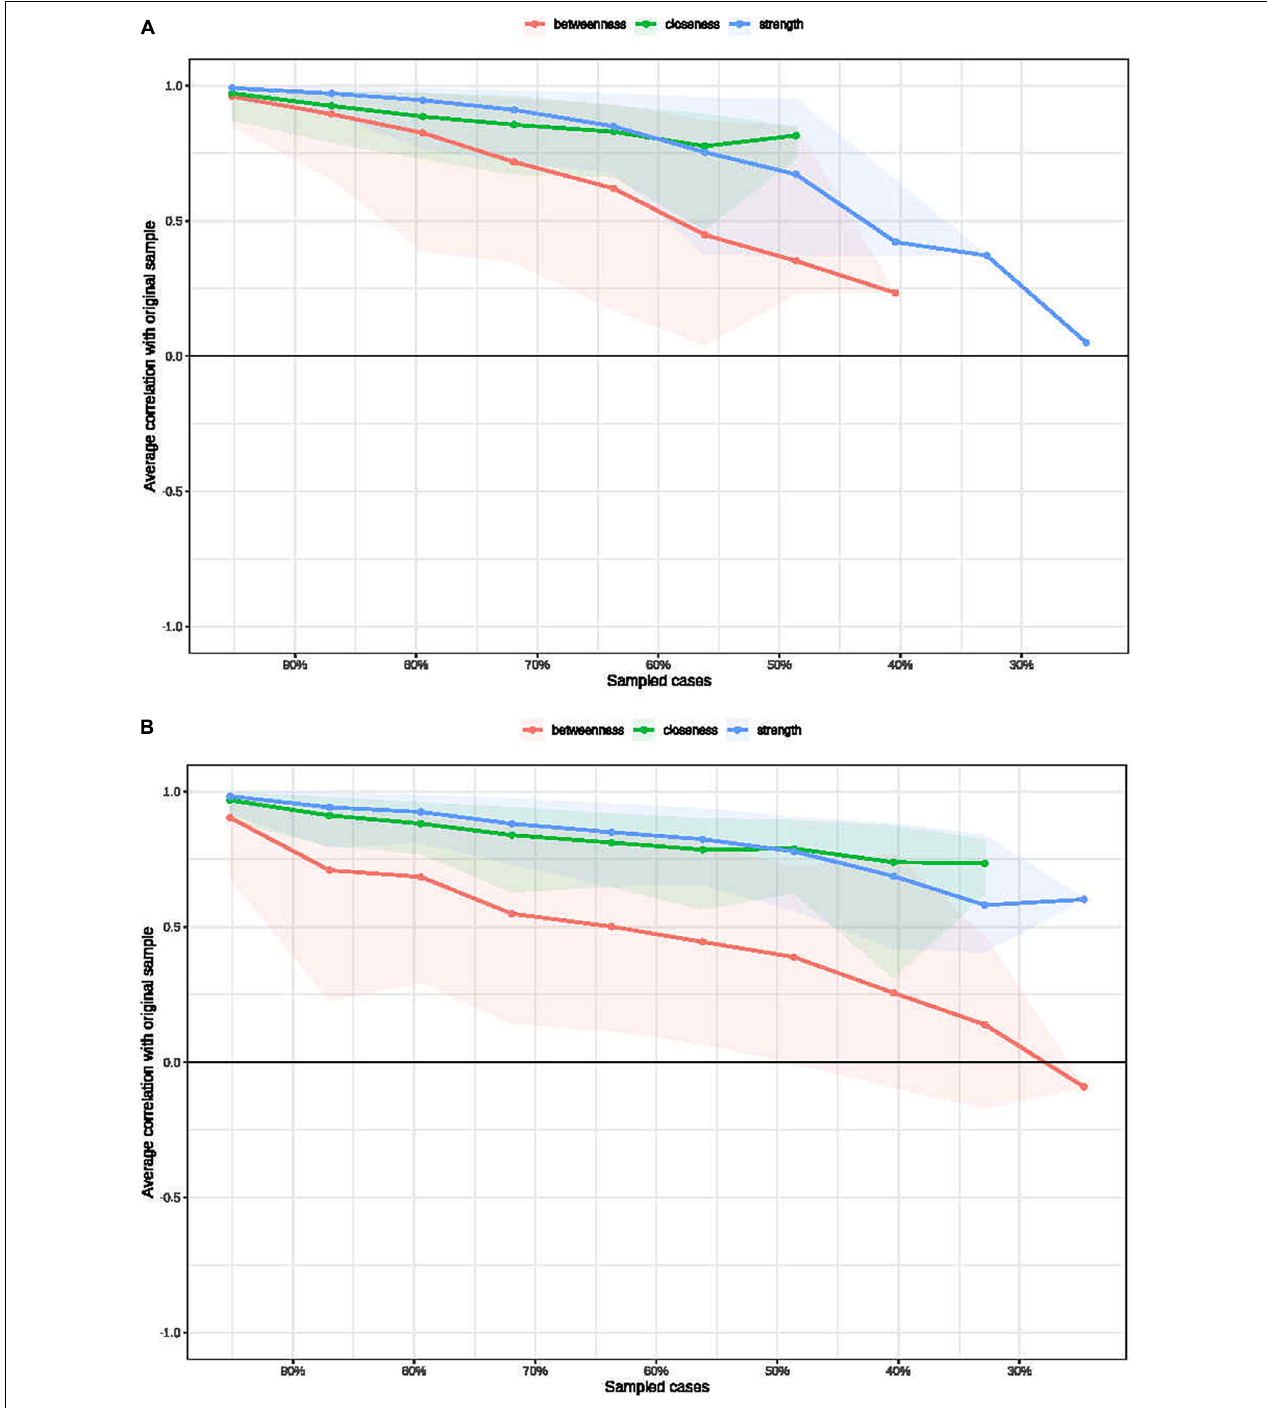
FIGURE 5 | Bootstrapped stability for the BN (A) and HC (B) graphical least absolute shrinkage and selection operator networks. The x -axis indicates the included portion of cases, and the y -axis indicates the average correlations with the original samples.